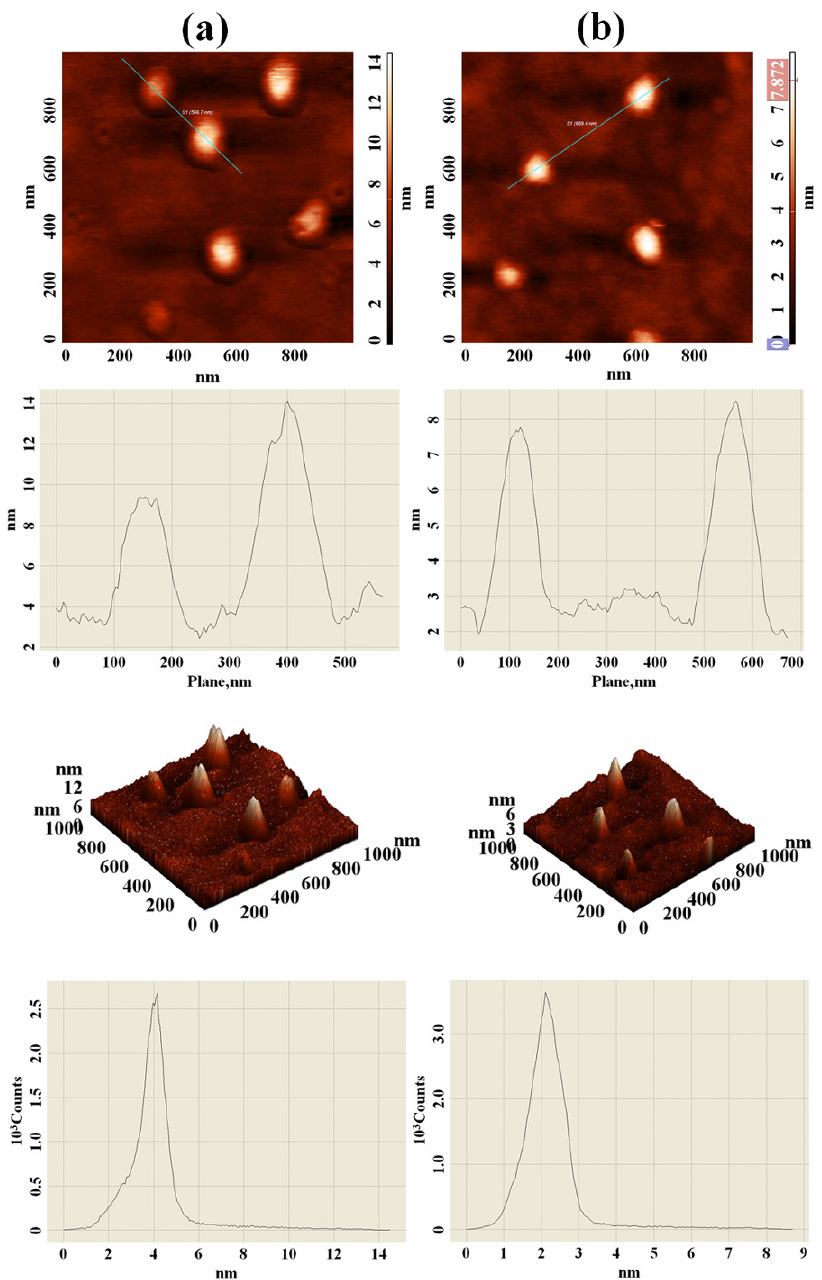
Figure 7. The AFM images of ZnO-PCEMA-Br-2 thin film before (a) and after (b) UV